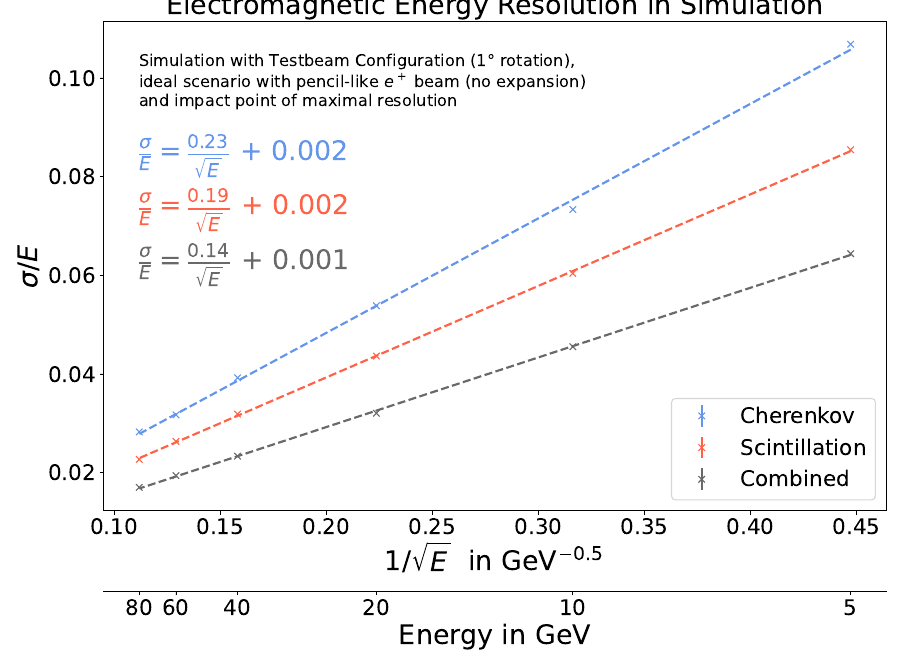
√ E for Cherenkov, scintillation, and Figure 7. Electromagnetic energy resolution as a function of 1/ combined channels. The simulation was conducted under an ideal scenario with exact knowledge of beam impact point, no material in front of the calorimeter prototype, and a slight rotation angle of 1°. For the Cherenkov and scintillation channel we extracted energy resolutions of √ √ E and 19%/ E , respectively, neglecting the constant term. This is in line with 23%/ the expectation that the scintillation channel performs better than the Cherenkov one